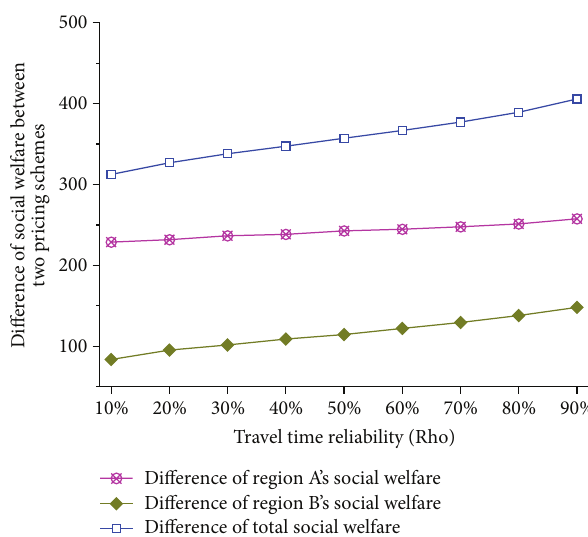
Figure 5: Benefit losses/gains in cooperation with different travel time